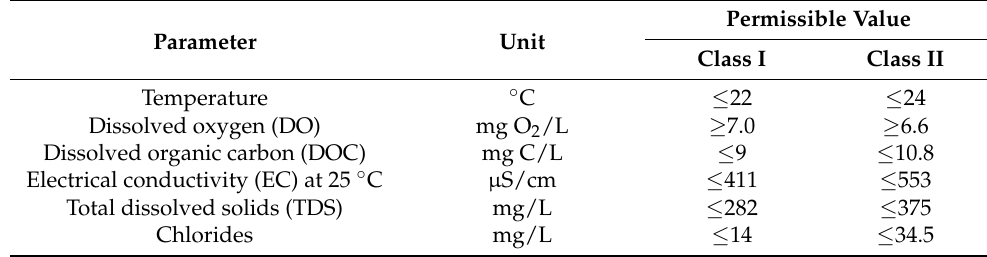
Table A2. The threshold values of the physicochemical and chemical parameters